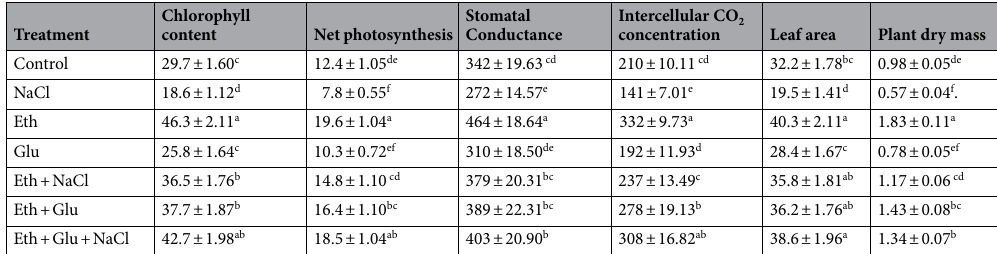
Table 1. Chlorophyll content (SPAD value), net photosynthesis (µmol CO 2 m −2 s −1 ), stomatal conductance (mmol CO 2 m −2 s −1 ), intercellular CO 2 concentration (µmol CO 2 mol −1 ), leaf area (cm 2 plant −1 ) and plant dry mass (g plant −1 ) of wheat ( Triticum aestivum L.) cv. WH 711 treated with 200 µL L −1 ethephon (Eth) and / or 6% glucose (Glu) in presence or absence of 100 mM NaCl at 30 d after sowing. Data are presented as treatment mean ± SE (n = 4). Data followed by same letter are not significantly different by LSD test at p <